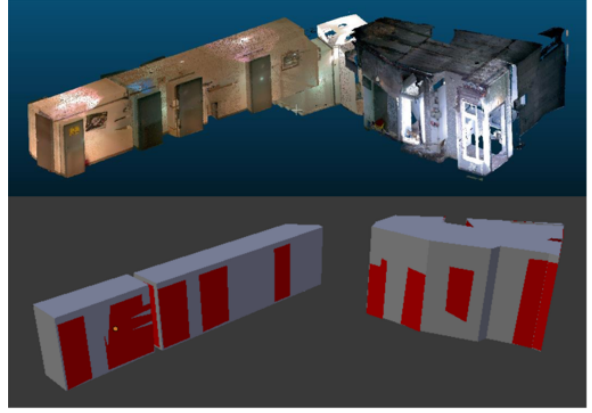
Figure 6. An example of building reconstruction